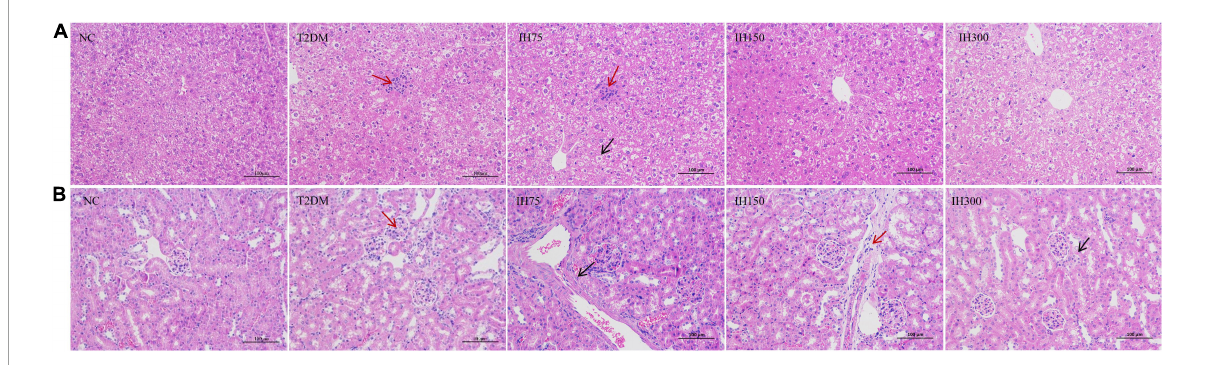
FIGURE4 Effects of IH on pathological changes in mice. Scale bar = 100 µ m. Representative H&E staining of liver (A) and kidney (B) tissue